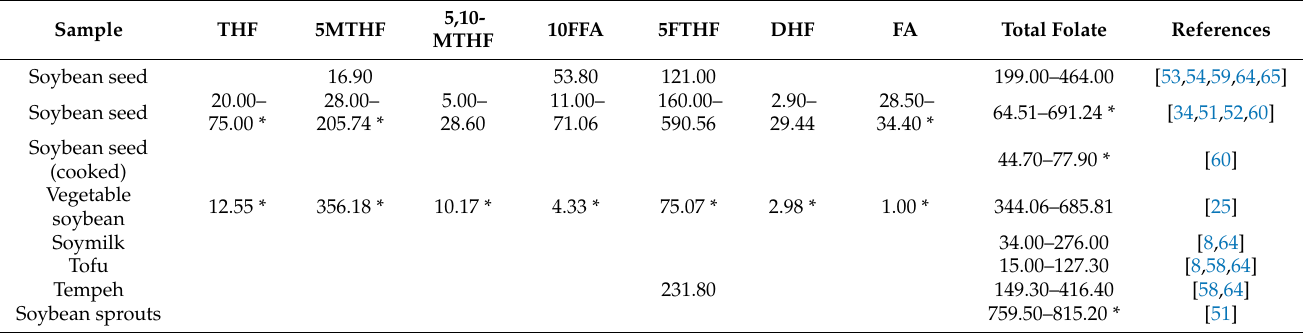
Table 3. The folate content of soybean seeds and soy-based